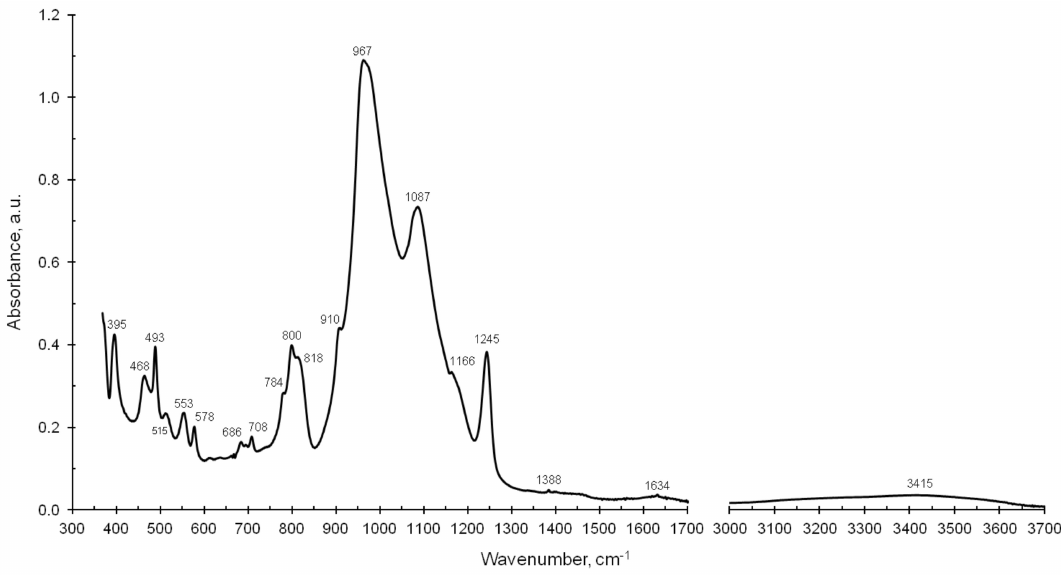
Figure 10. IR spectrum of rippite in the 350–1700 and 3000–3700 cm − 1 ranges (powder KBr